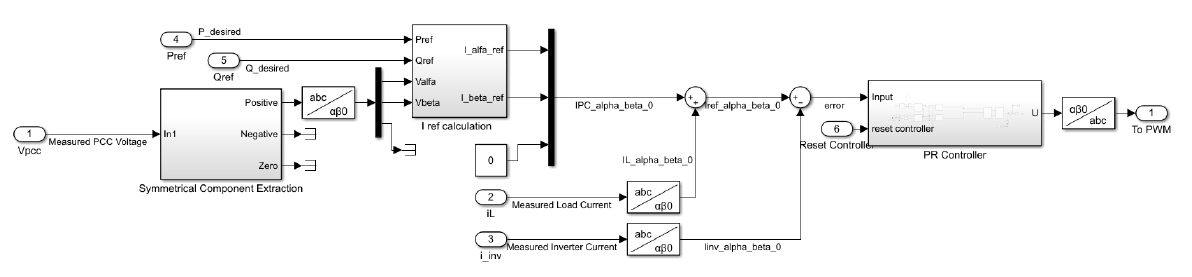
Figure 8. The complete block diagram of the proposed method.